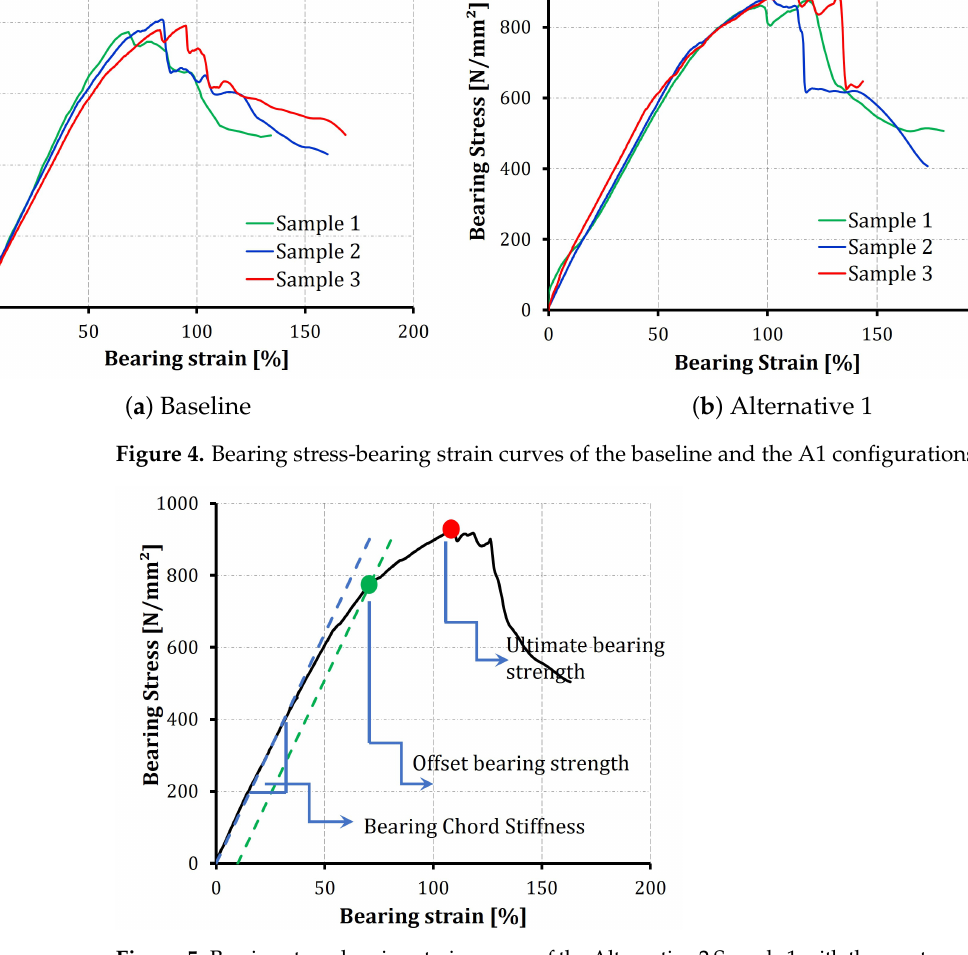
Figure 5. Bearing stress-bearing strain curves of the Alternative 2 Sample 1 with the most common